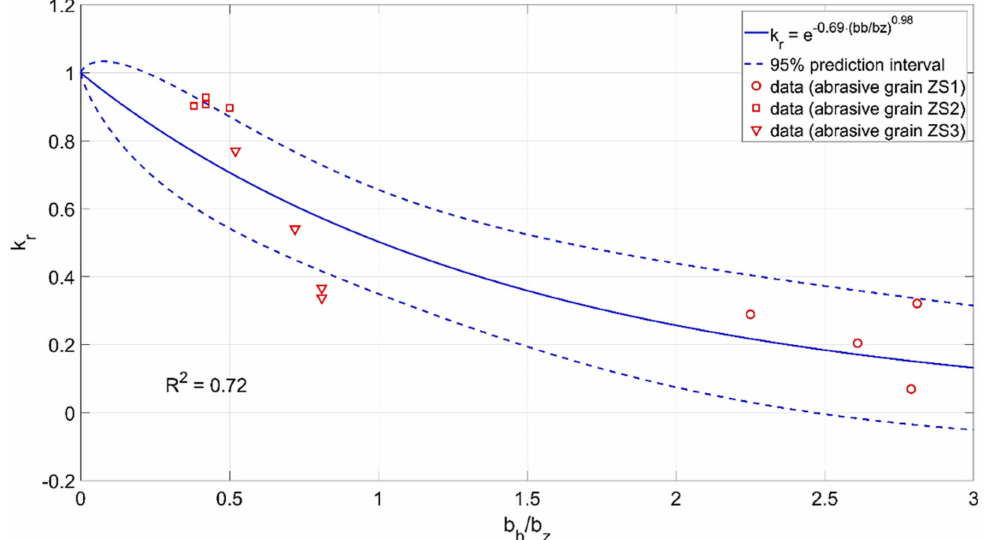
Figure 20. Influence of the coefficient b b / b z of the abrasive grain on the material removal efficiency k r